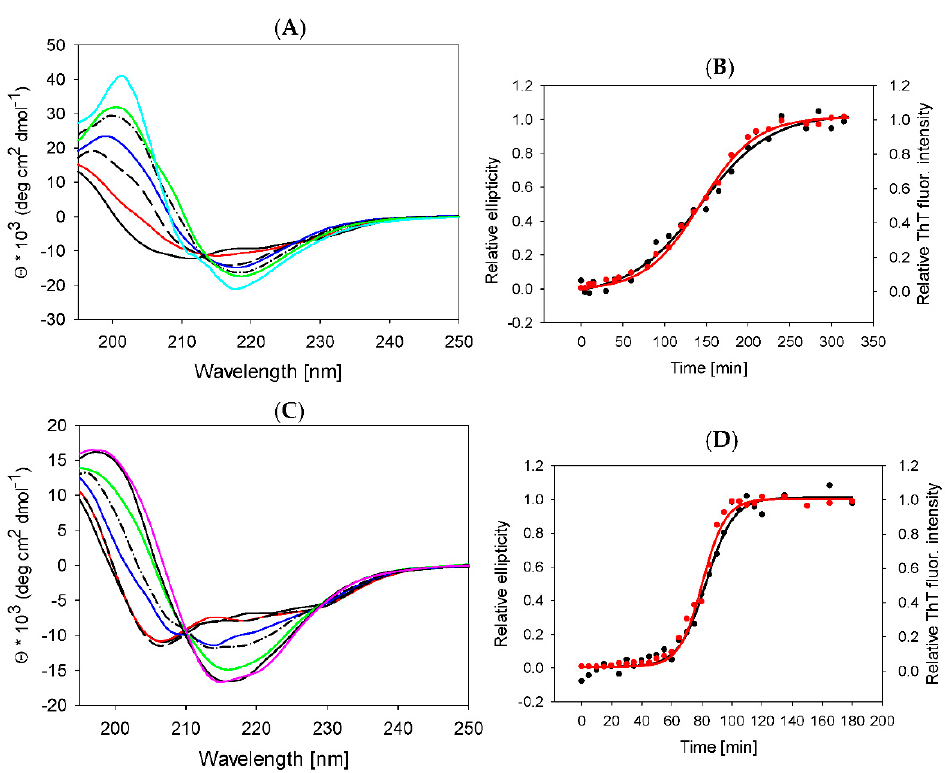
Figure 4. Far UV − CD spectra of lysozyme in 1% EMIM-ac ( A ) and 1% EMIM-BF 4 ( C ). The samples were withdrawn at different time points of fibrillization (identical time point as used for the ThtT kinetics measurement). The arrows indicate the order of spectra with increasing time. A reduced number of spectra is shown for better readability. ( B , D ) Time dependence of the normalized value of mean residue ellipticity at 218 nm for all measured spectra—black circles, ThT fluorescence intensity—red circles (taken from Figure 1A).